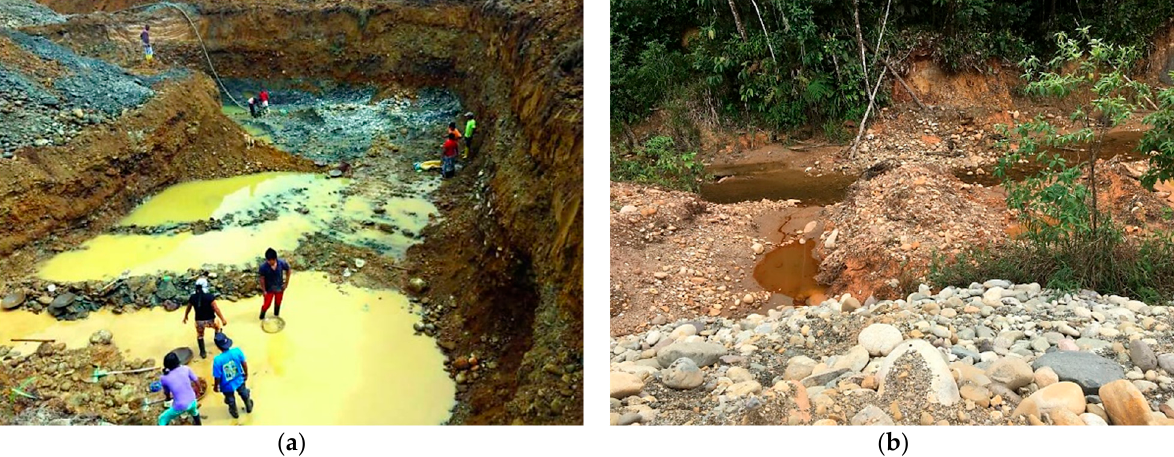
Figure 2. Gold mining impacts. ( a ) Pools of contaminated water exposed in the open pit; ( b ) debris generated by the extraction of material for gold.